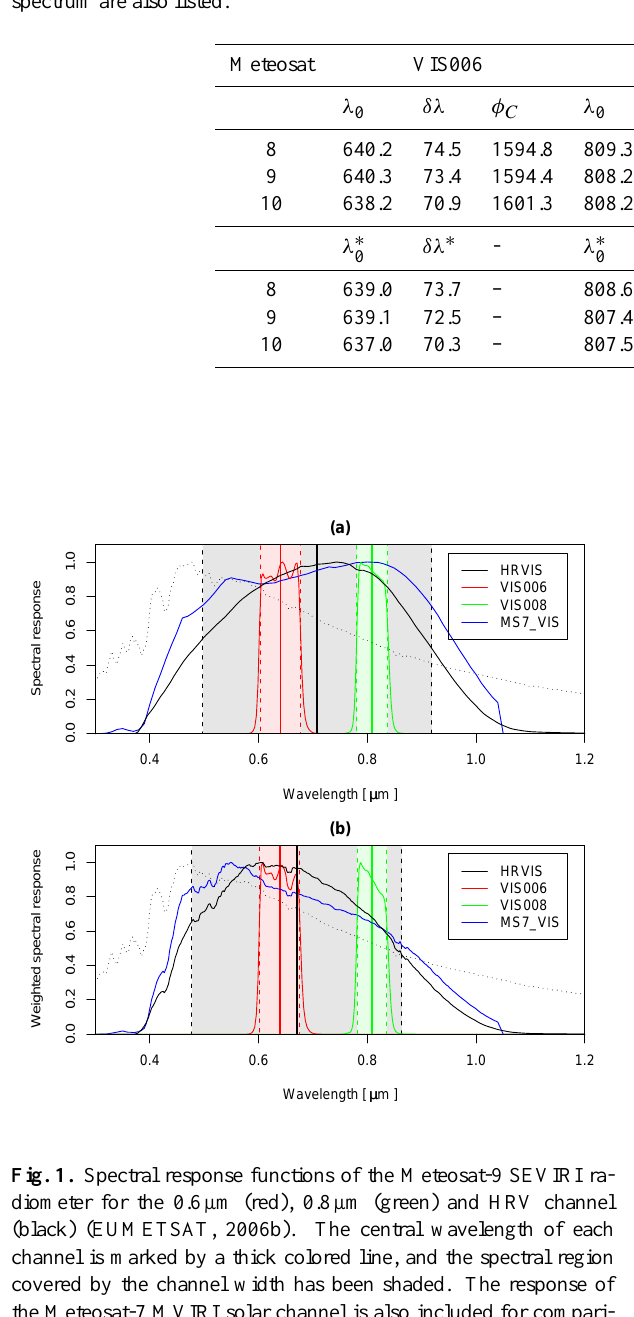
Table 1. Central wavelength λ 0 , channel width δλ (both in nm), and band-averaged extraterrestrial solar spectral irradiance φ C (W/m 2 /µm) at a sun-earth distance of 1 astronomical units for the SEVIRI radiometers onboard the Meteosat-8 to 10 satellites and for the 0.6µm (VIS006), 0.8 µm (VIS008) and HRV channels, calculated from the spectral response functions provided by EUMETSAT (2006b) and the solar spectrum of Gueymard (2004). The central wavelength λ ∗ and channel width δλ ∗ for the spectral response weighted by the solar 0 spectrum are also listed.